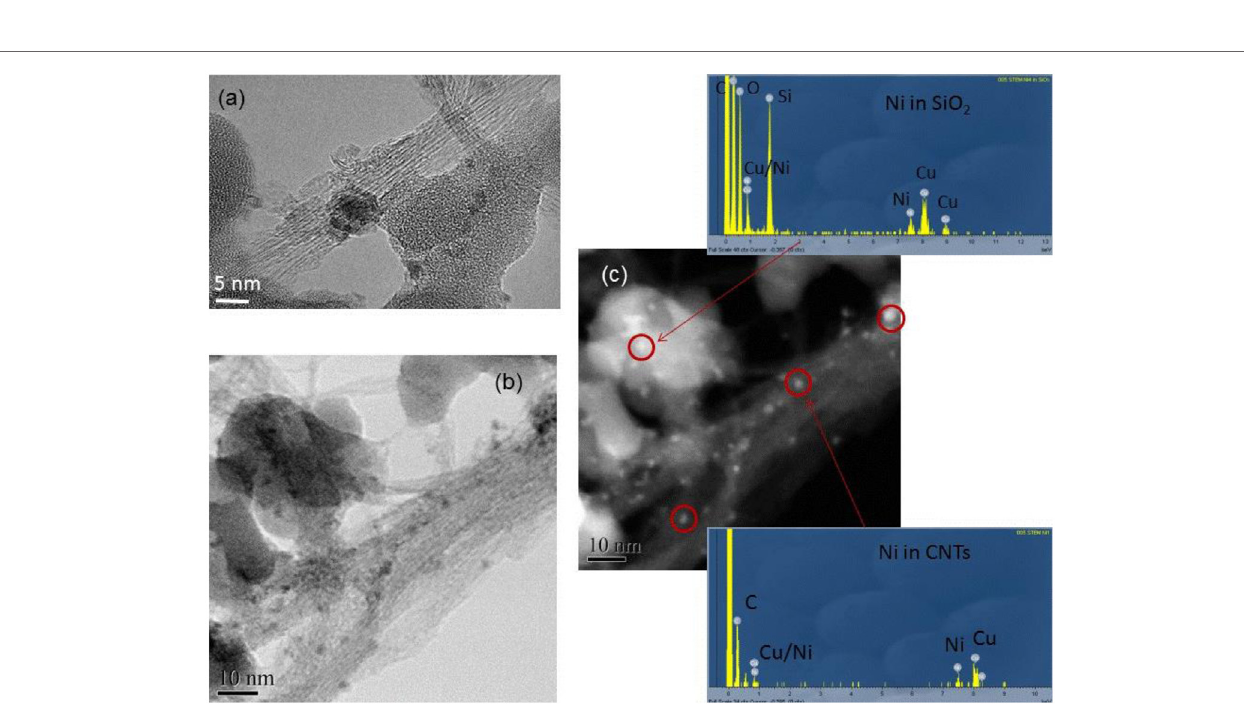
FigUre 2 | (a) TEM image of the as-made SWCNTs on silica support; (B) STEM image of the SWCNTs in bright field; (c) STEM image of the area shown in (B) in dark field. The EDX spectra were acquired from the nanoparticles circled in red in (c)